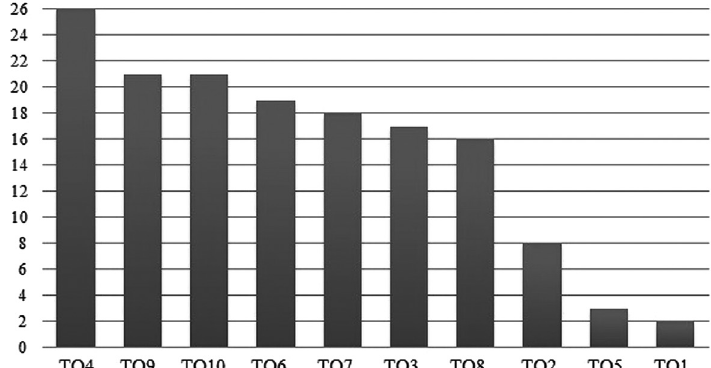
Fig. 5. Frequency of investment indications under thematic objectives in 26 ITI strategies. Source: own